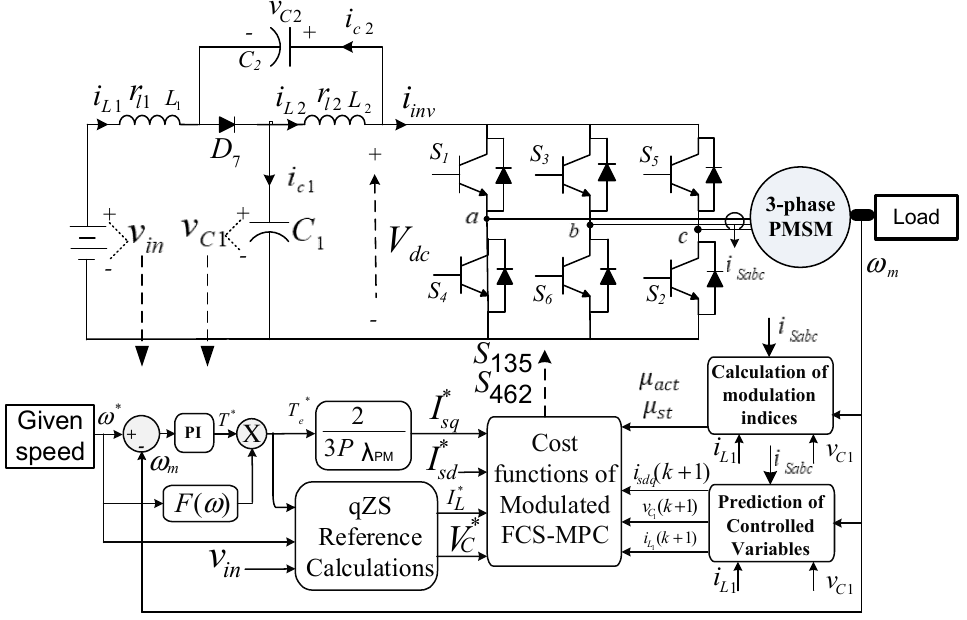
OFF ON V4 OFF ON OFF ON OFF ON V5 OFF ON ON ON OFF OFF V6 OFF OFF ON ON ON OFF V7 ON OFF ON OFF ON OFF ST Shoot-through state V8 ON ON ON ON ON